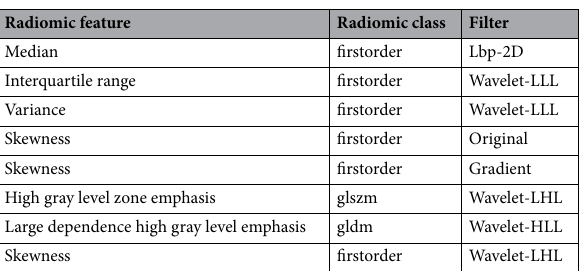
Table 3. Description of selected radiomic features with their associated feature group and filter based on T 2 WI. GLDM gray-level dependence matrix, GLSZM gray-level size zone matrix.